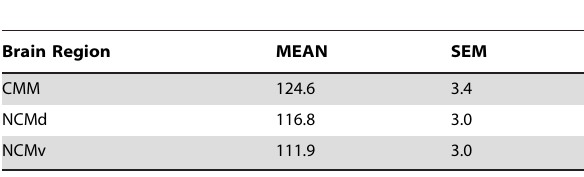
Table 3. Mean and Standard Error of the Mean of the Number of Cells for CMM, NCMd, and